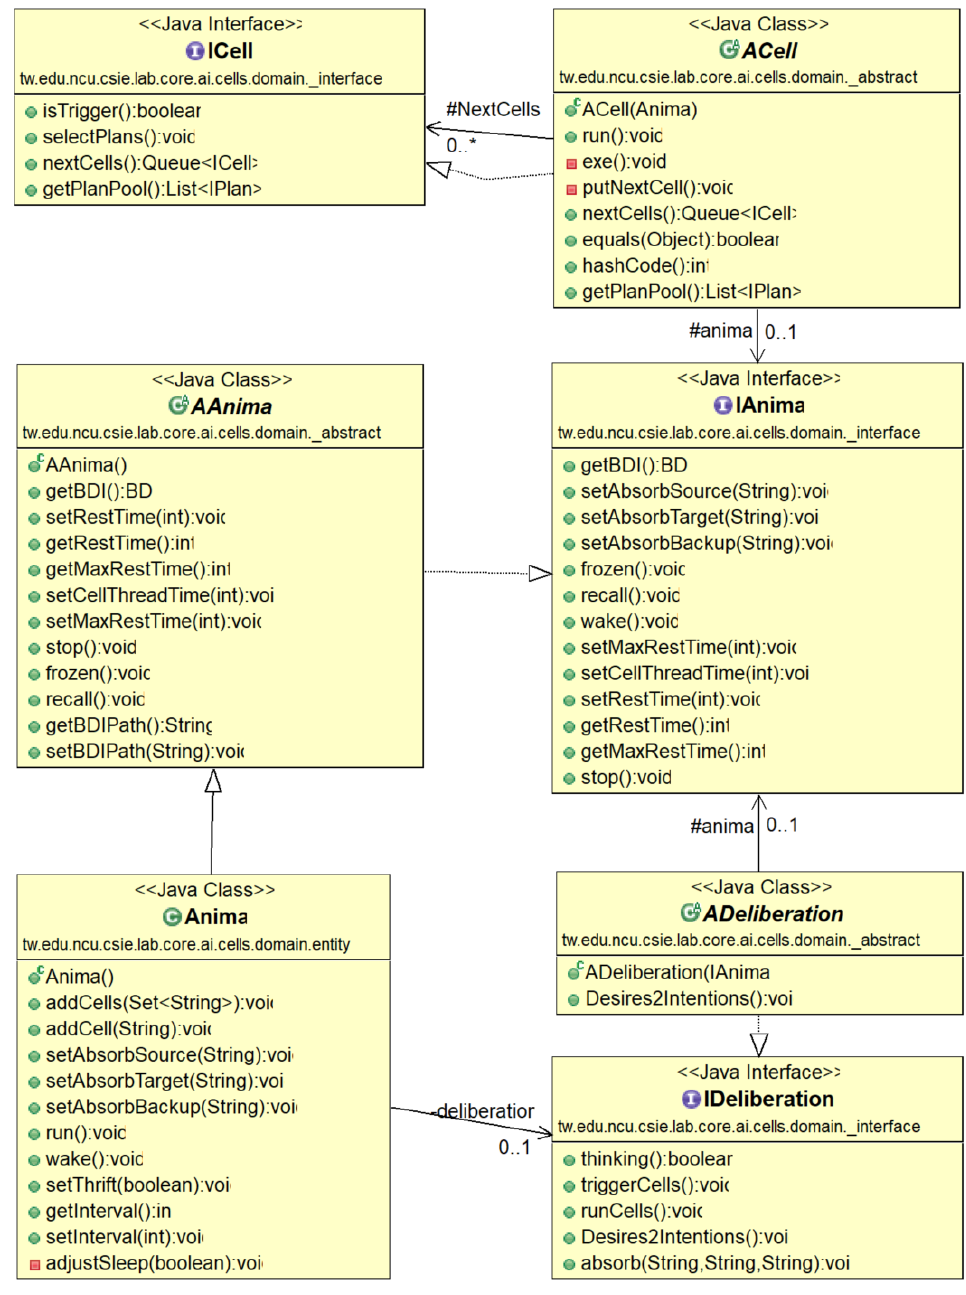
Figure 5. This is the class diagram from the single-anima perspective.